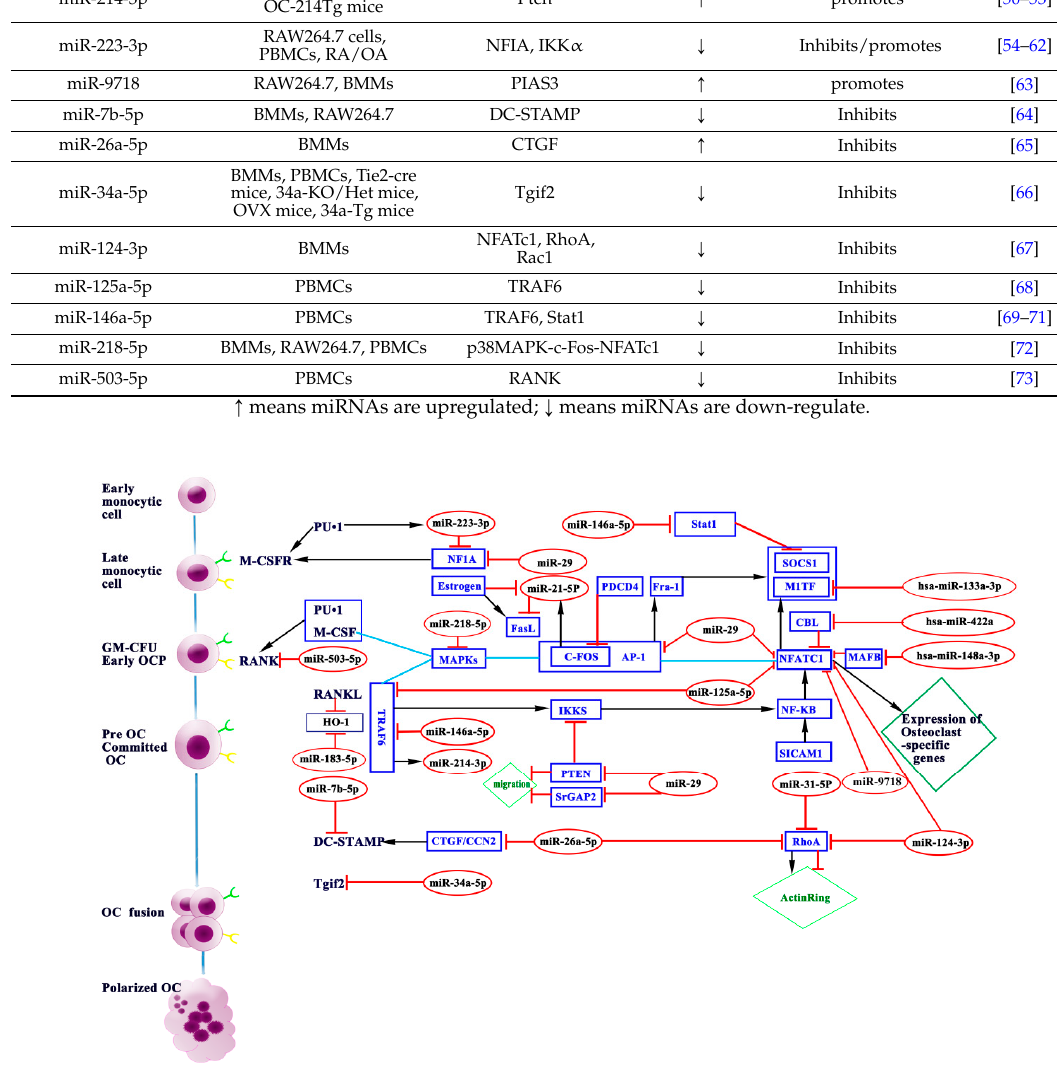
Figure 2. miRNAs modulate osteoclast differentiation and function. Through repressing varieties of target genes, miRNAs participate in osteoclast differentiation and maturation. Blue boxes indicate targets of miRNAs. Red ovals indicate miRNAs involved in osteoclastogenesis. Green receptors indicate M-CSFR, and yellow receptors indicate RANK.